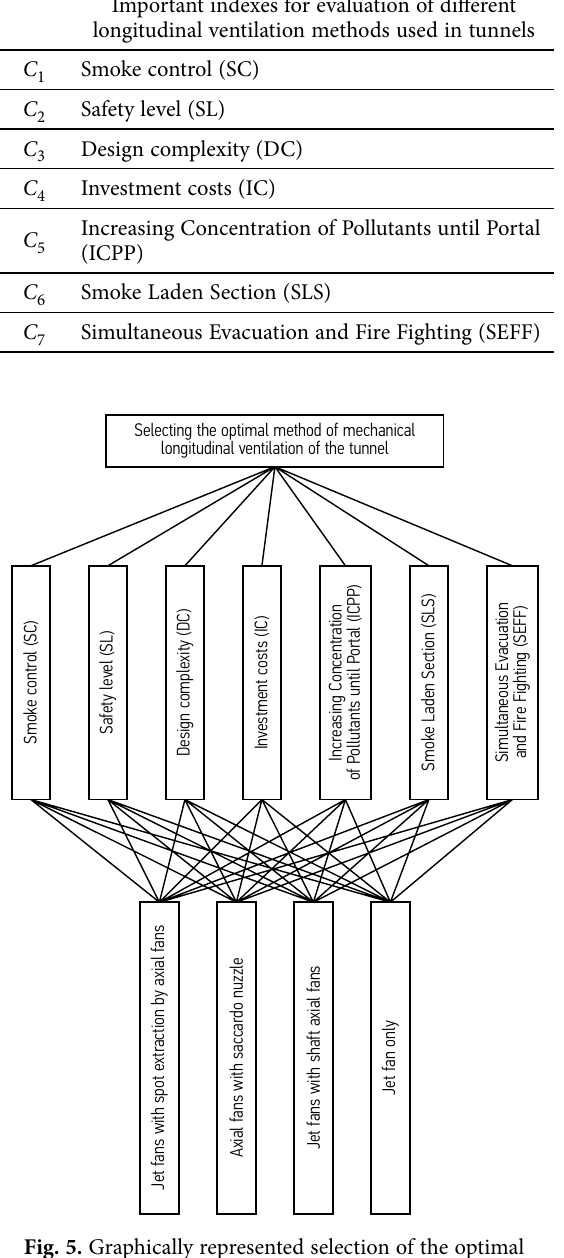
Fig. 5. Graphically represented selection of the optimal mechanical longitudinal ventilation method